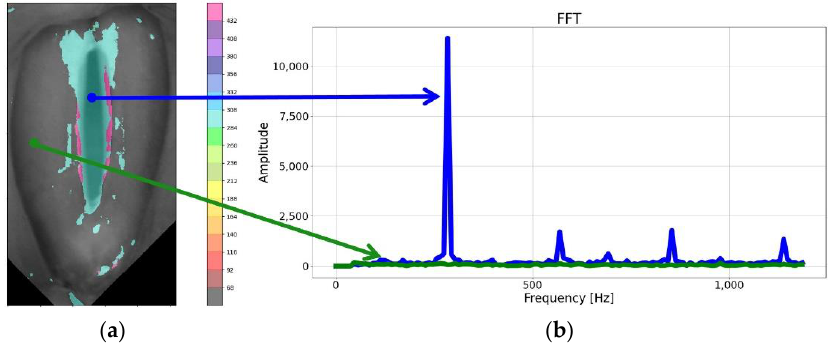
( b ) Figure 3. Identification of the region of interest for further image analysis procedures: ( a ) vocal fold area delineated with b-spline curves represented by blue line and the user-defined interpolation nodes, ( b ) identification of the left (grey shaded) and the right (orange shaded) vocal folds. Next, for each pixel coordinate in the image ’s region surrounded by the B-spline curve, a signal was constructed representing changes in the brightness of this pixel in the analyzed HSV recording of the larynx (step 4 in Figure 2). The signal was called the bright- ness function and took values in the range of 0 – 255, i.e., over the entire brightness range of the image. As can be seen in Figure 2, the brightness function was a periodic function for which the fundamental frequency F 0 could be determined. For this purpose, we calculated a Fourier transform of this function. The Fourier amplitude spectrum is shown below the brightness function plot in Figure 2. Note the elevated maximum in the Fourier spectrum indicating the fundamental frequency F0 . The procedure described above was performed for each pixel in the HSV recording of the larynx. On this basis, we could create laryn- gotopographic maps in which we used colors to label areas of the glottis showing regular periodic movements at the fundamental frequency F 0. An example of the laryngotopo- graphic map superimposed on the grayscale image of the glottis is shown in Figure 4a. Note the arrows coming from two different regions of the image. The blue arrow origi-